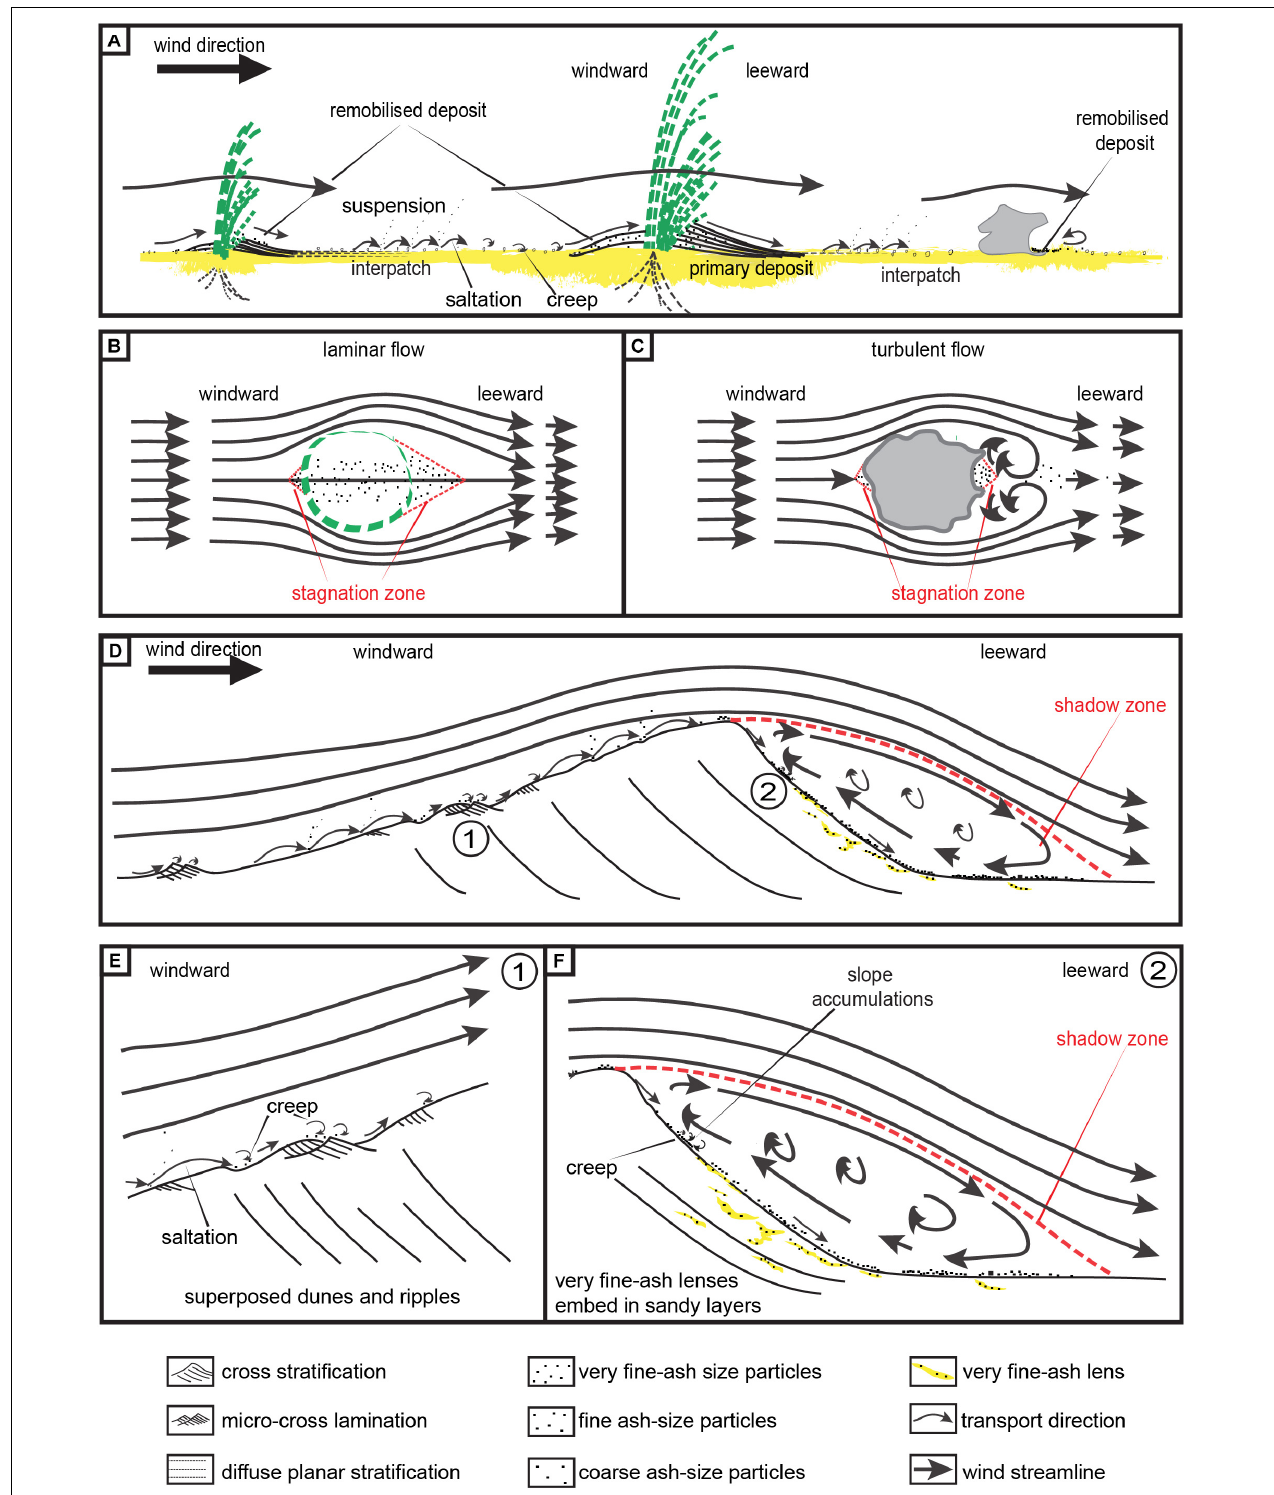
FIGURE 11 | Cartoons showing transport and deposition mechanisms for remobilised ash: (A) deposits associated with roughness elements (e.g., vegetation and rocks); plan view of processes associated with (B) laminar and (C) turbulent flow regimes; (D) ash remobilisation processes associated with pre-existing mounds; (E) detailed view of ripple formation (label 1 in D ); (F) detailed view of shadow zone processes (label 2 in D ). Bold arrows indicate wind streamlines. Cartoons not to scale.